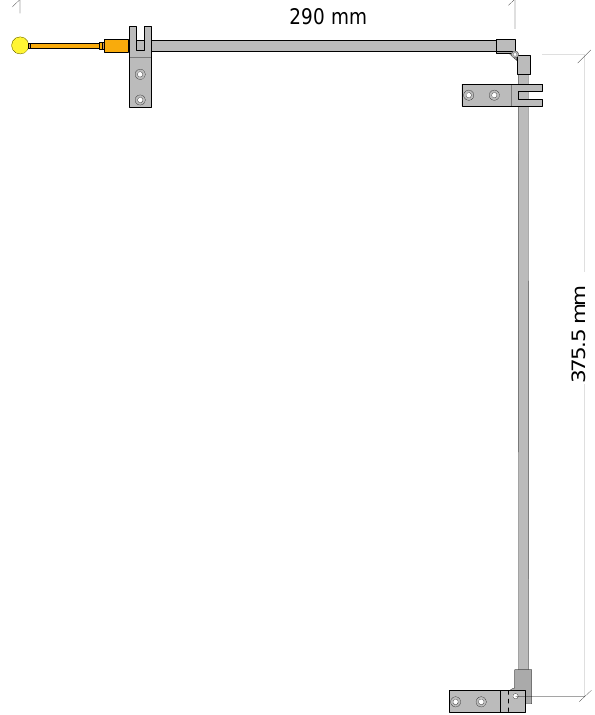
between them, varied dependent on mode of operation. An example spectrogram of 1I/I data is given in panel 4 of Fig. 2.